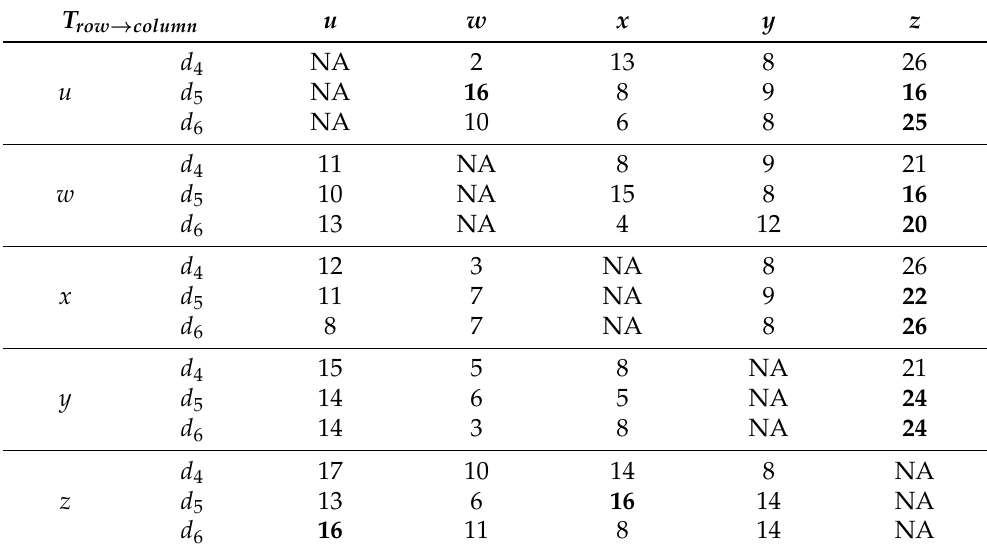
Table 5. Sum of cases where the Transfer Entropy coefficient in a row for a given variables pair is the highest—1st variant (49 subdatasets).